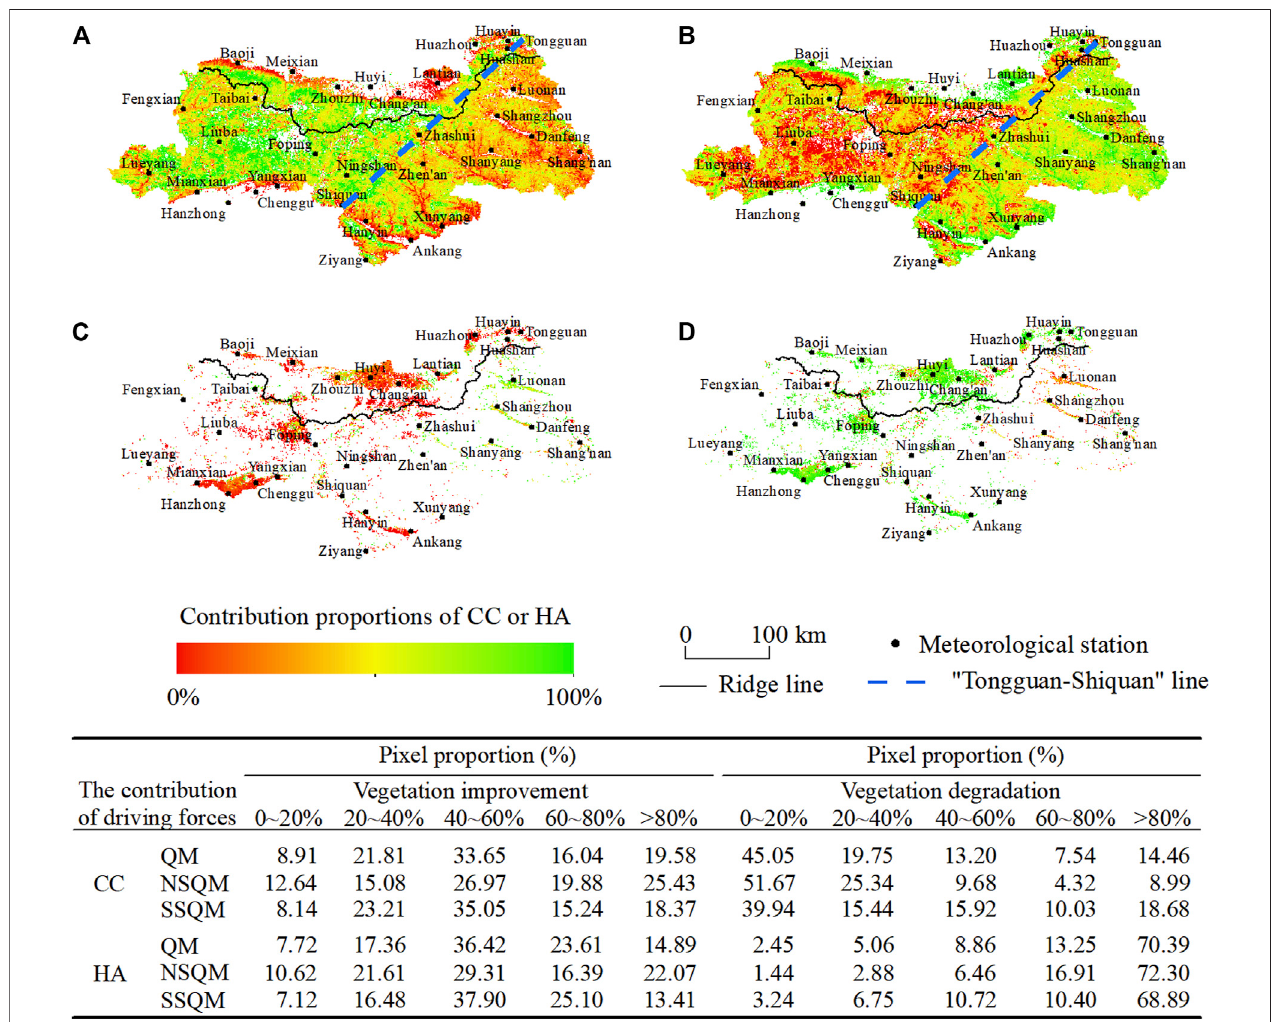
FIGURE6| Spatialdistributionsofthecontributionproportionsof (A) climatechangeand (B) humanactivitiestovegetation improvement, (C) climate change,and (D) human activities to vegetation degradation in the Qinling Mountains (CC, climate change; HA, human activities in the fi gure).